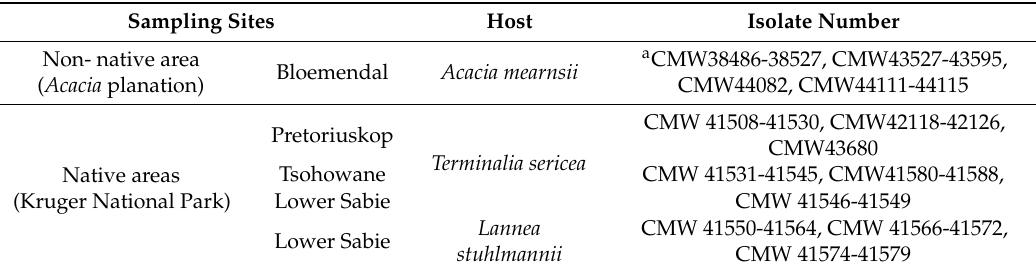
Table 1. Isolates of Ceratocystis albifundus used in this